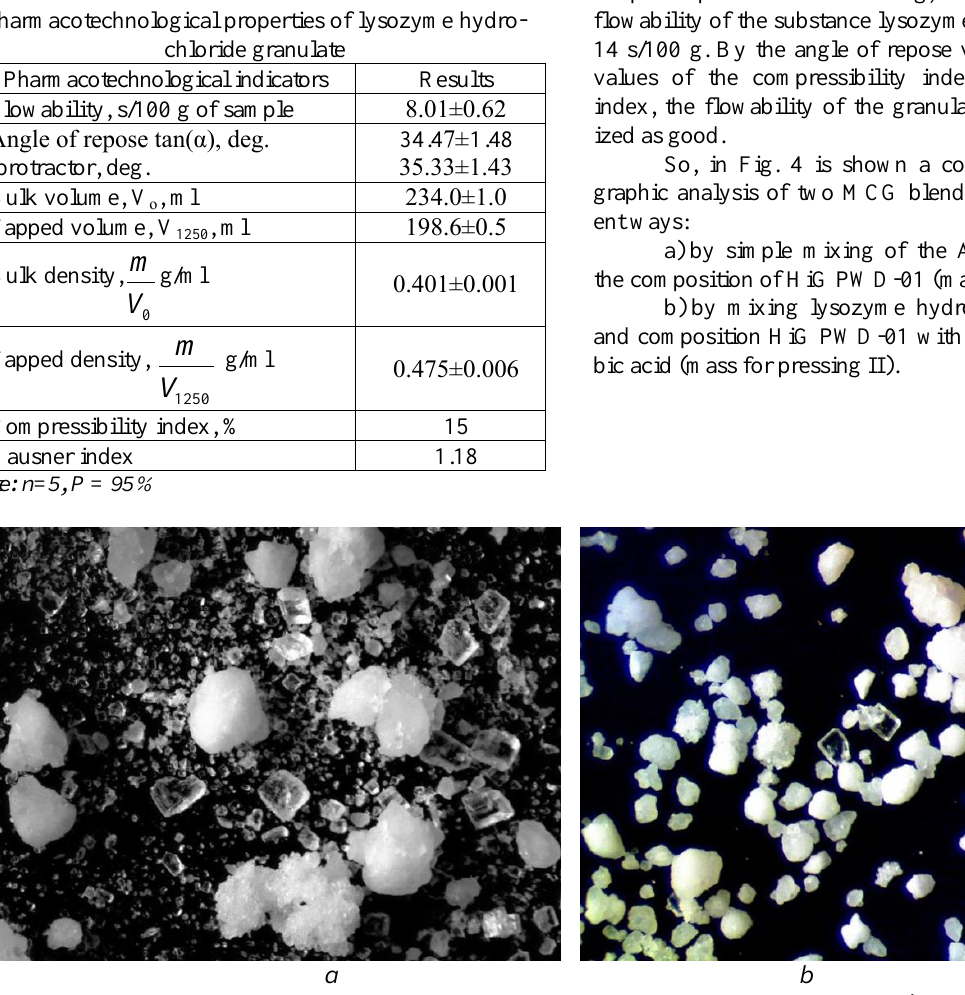
Fig. 4. Comparative crystallographic analysis of two MCG blends: а – mass for pressing I; b – mass for pressing